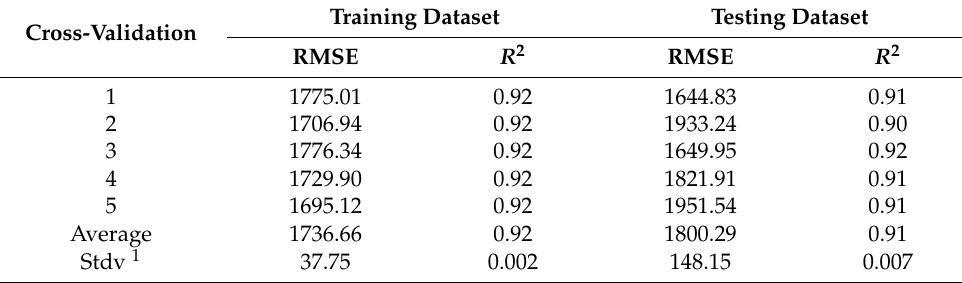
Table 4. Five-fold cross-validation accuracy results of the proposed model. Cross-Validation